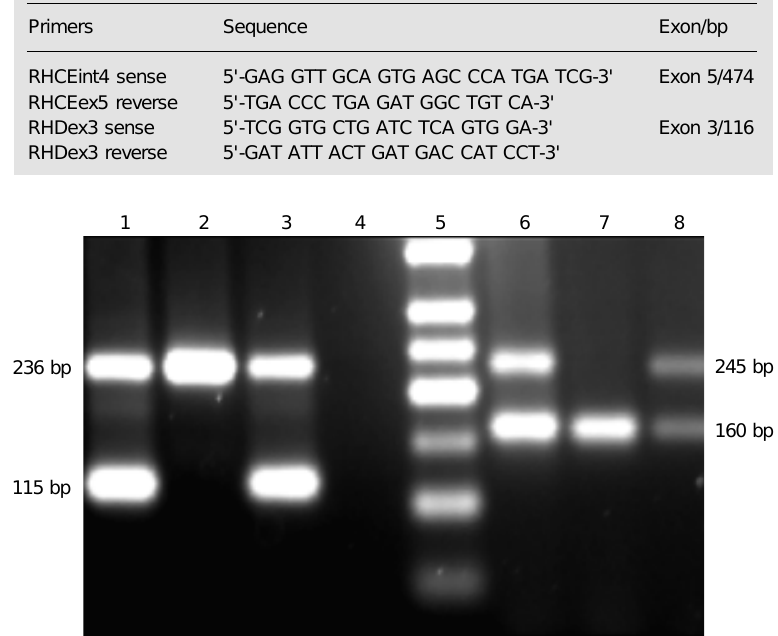
Table 4. Primers used for sequence analysis of VS and D-CE